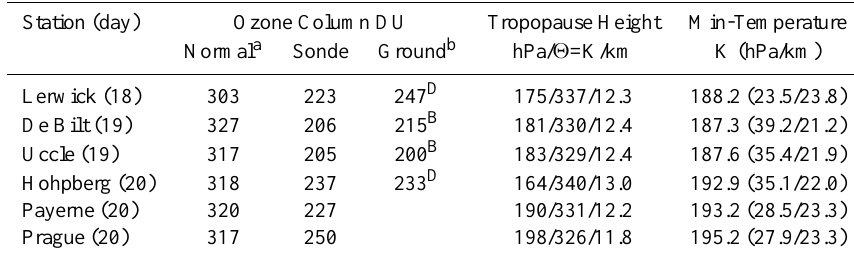
Table 3. Measured parameters, describing the very low total ozone episode around 19 January 2006. Stations are listed according to the day of minimum total